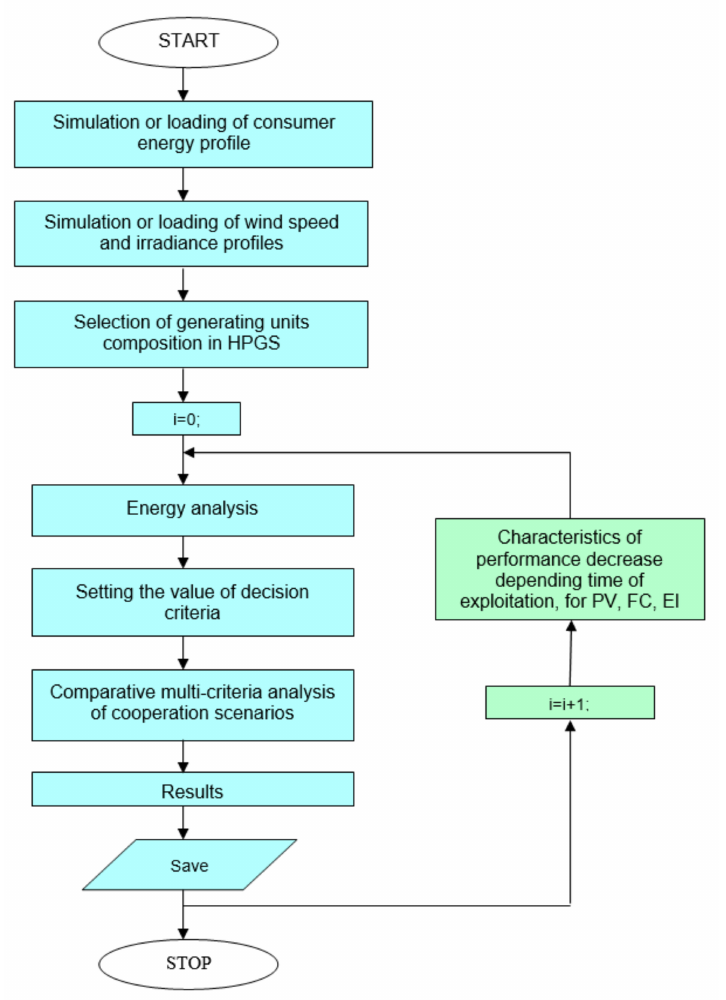
Figure 2. Block diagram of the model used to determine HPGS and NPS load distribution taking into account performance decrease characteristics of the PV, FC, and